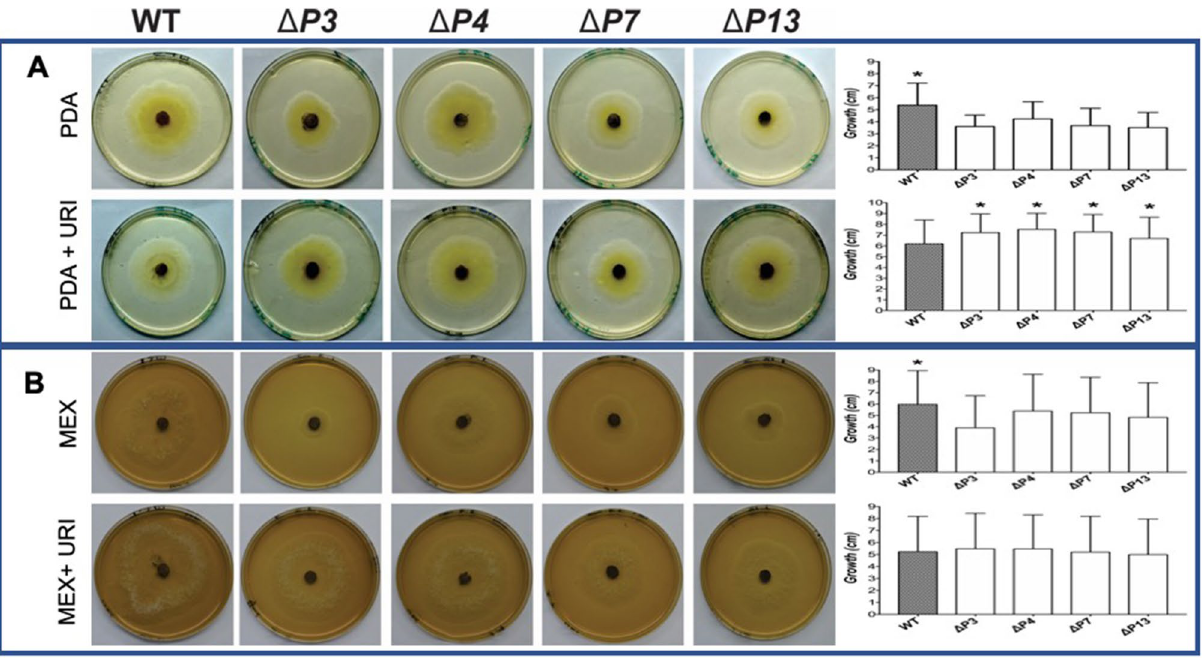
Figure 2. Phenotype analysis of T. harzianum mutants for uridine auxotrophy. T. harzianum wild-type and mutants ( ΔP3 , ΔP4 , ΔP7 , and ΔP13 ) were grown at 28 °C in absence or presence of uridine. Pictures after 2 days from bioassays conducted in PDA ( A ) and MEX ( B ) media. *Bars marked with asterisk differ significantly ( P < 0.05).